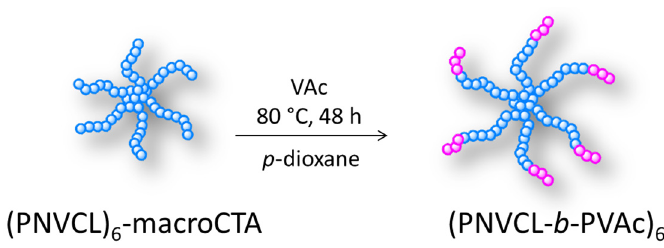
Table 2. Characteristics of the star (PNVCL- b -PVAc) 6 copolymers.